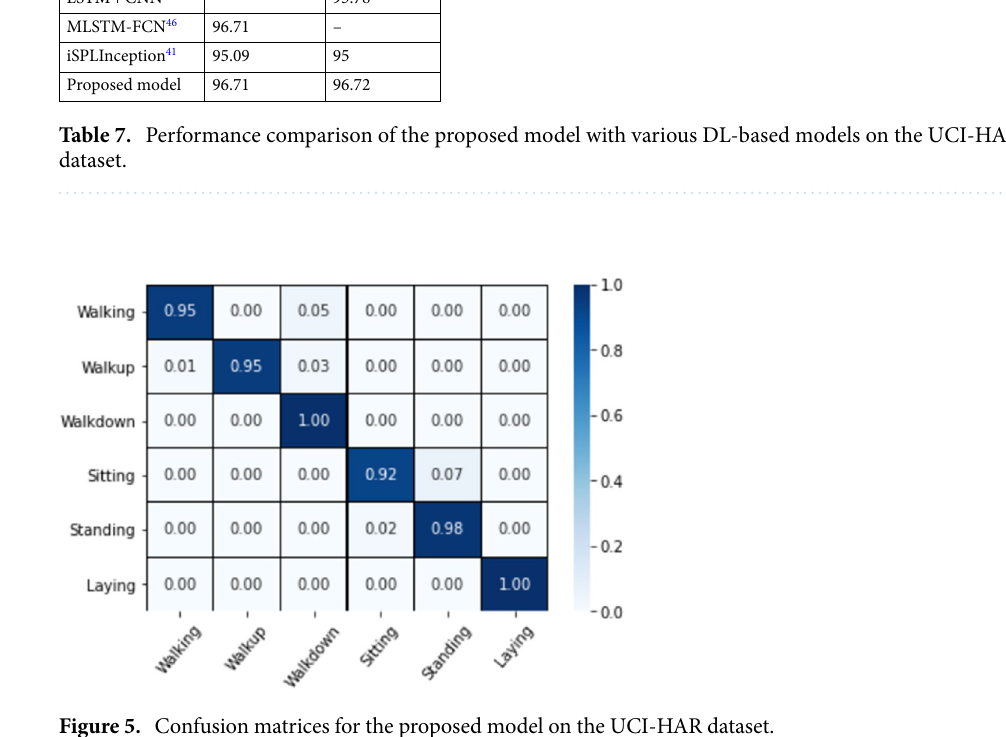
Figure 5. Confusion matrices for the proposed model on the UCI-HAR dataset.